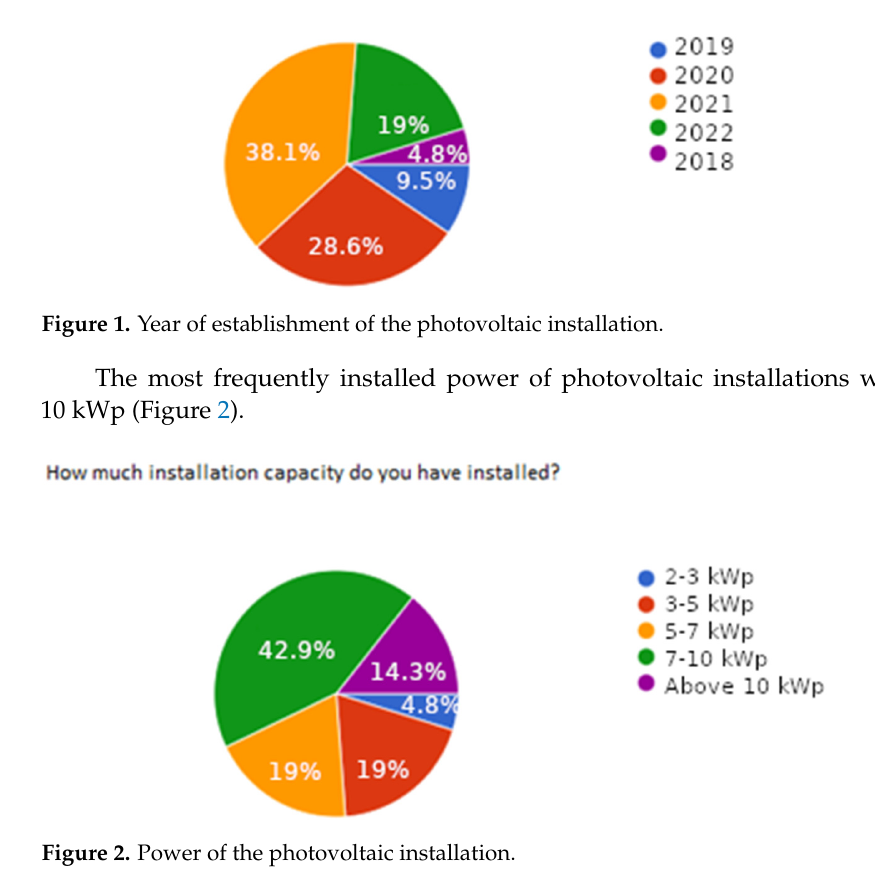
Figure 2. Power of the photovoltaic installation.